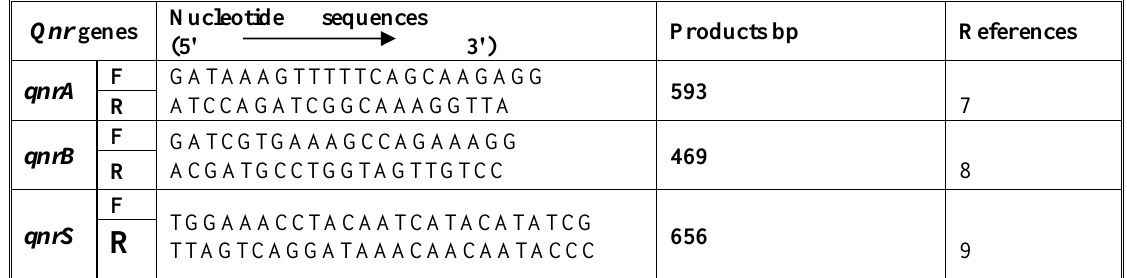
Table 1. Primer nucleotide for identification of plasmid-mediated quinolone-resistance genes Qnr